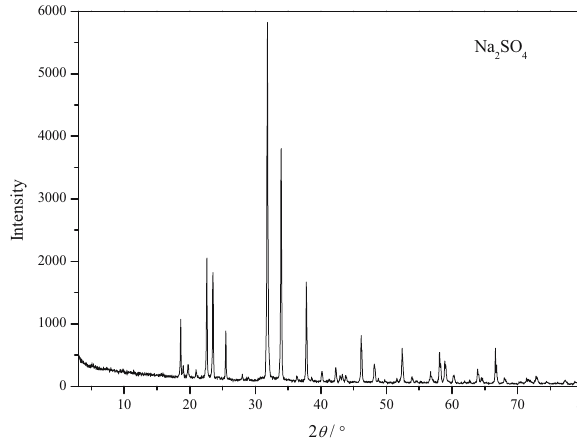
Figure 9: XRD pattern of sodium sulfate ( HWWS - SS )